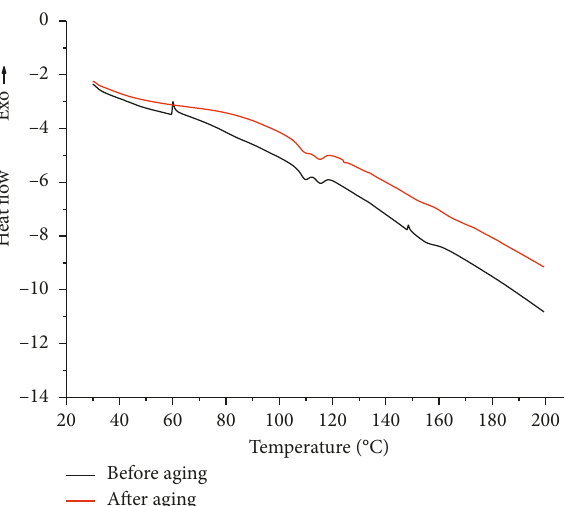
Figure 8: DSC curves of WPP/OREC-1.5-modified asphalt before and after